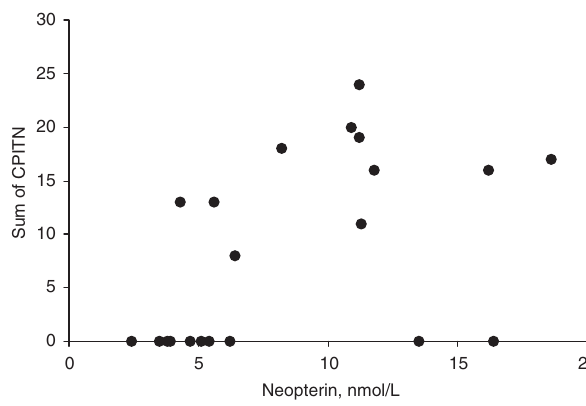
Figure 2: The correlation between salivary neopterin and community periodontal index of treatment needs (CPITN) in 21 oral = 0.504, p = 0.020). cancer patients (r s